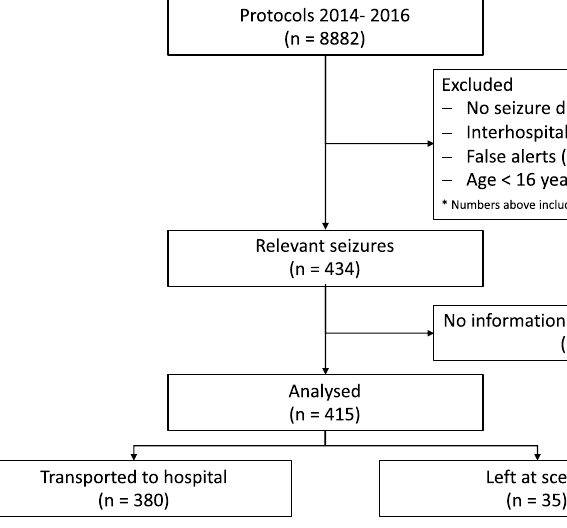
Figure 1. STROBE diagram.